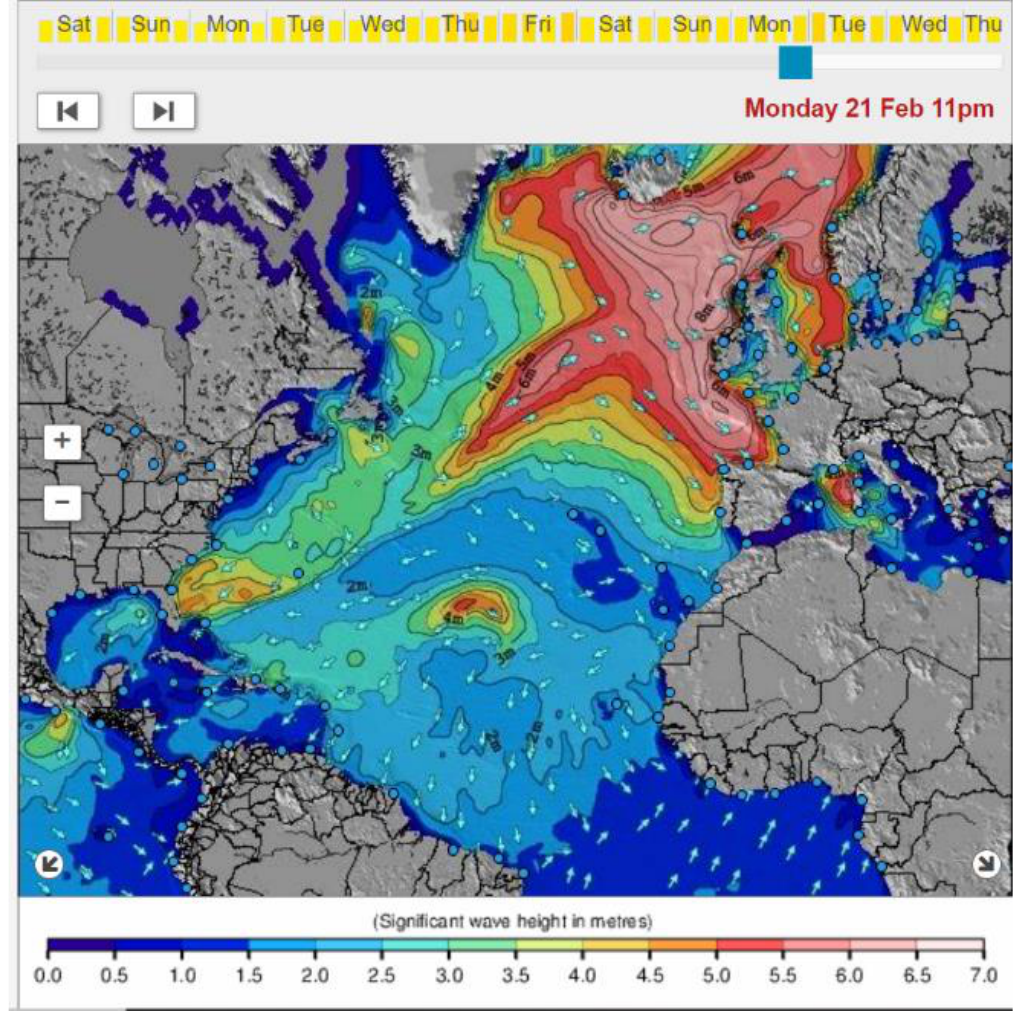
Figure 2. Print screen of the wave height forecast published on the website pt-surf-forecast.com.